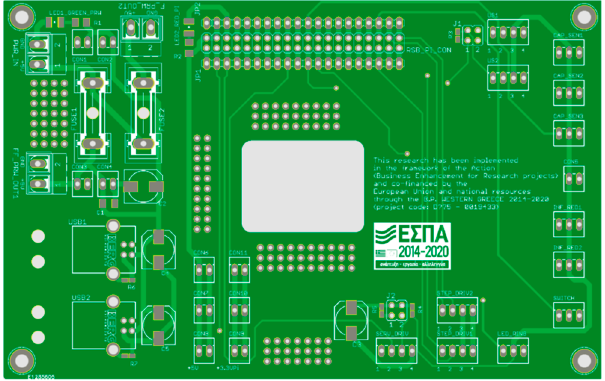
Figure 3. Printed circuit board of our robot .